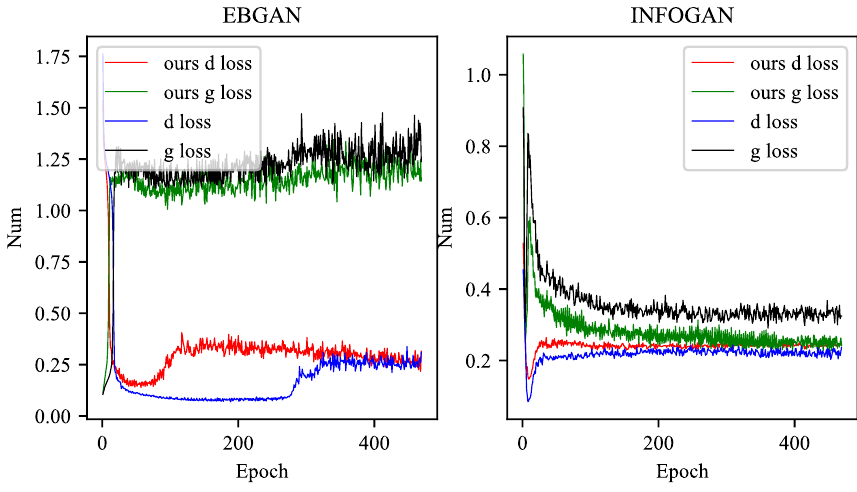
Figure A2. The results of the EBGAN [10] and INFOGAN [32] model.